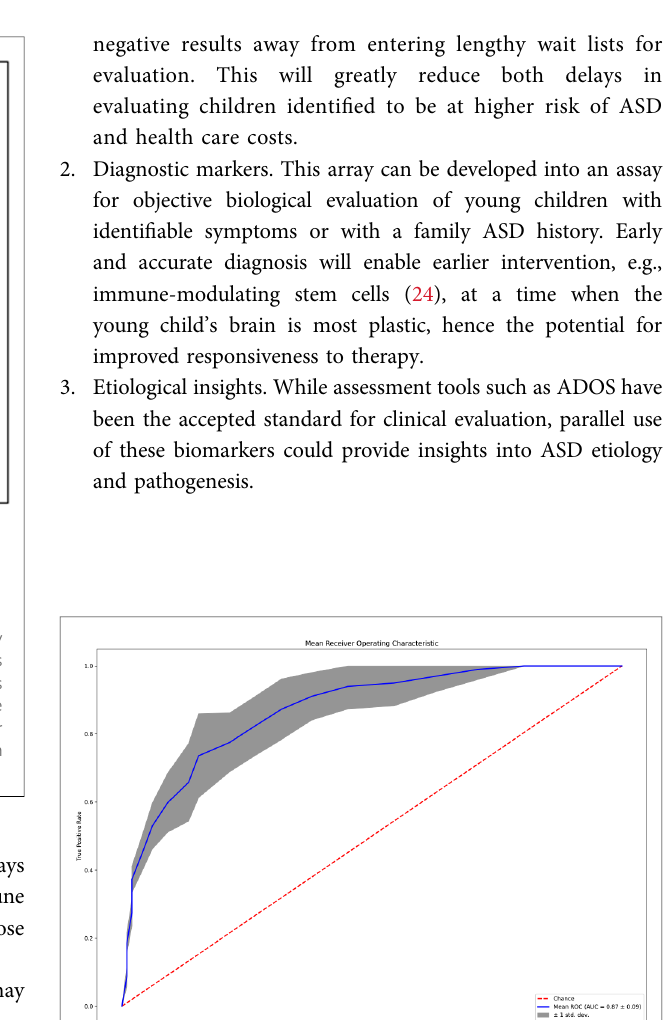
speci fi city of 84.6%, with all markers associated with pathways implicated in ASD, including negative regulation of immune function. Of note, none of the biomarkers overlapped with those identi fi ed in the current study.